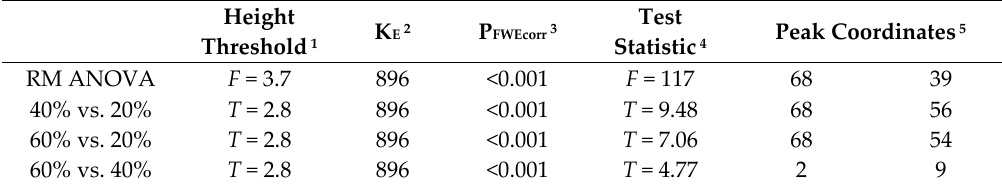
Figure 2. Statistical parametric mapping (SPM) repeated measures (RM) one-way ANOVA inference images when comparing medial gastrocnemius high-density electromyography maps from contractions at different intensities. ( a ) Inference image for the SPM RM one-way ANOVA result; ( b – d ) post-hoc inference images for comparisons between submaximal activity levels. For each inference image, the critical threshold for statistical significance at α = 0.05 is presented at the lower boundary of the color bar (dark blue). If the SPM ({F} or {T}) comparison crossed the threshold, the test statistic result is presented as a pixel (in the green-yellow range) in the image. Thus, pixels closer to the top boundary of the color scale (yellow) depict an area in the muscle where a larger EMG amplitude difference was found. Table 1. SPM statistics when comparing topographic maps before and after repeated bouts of eccentric